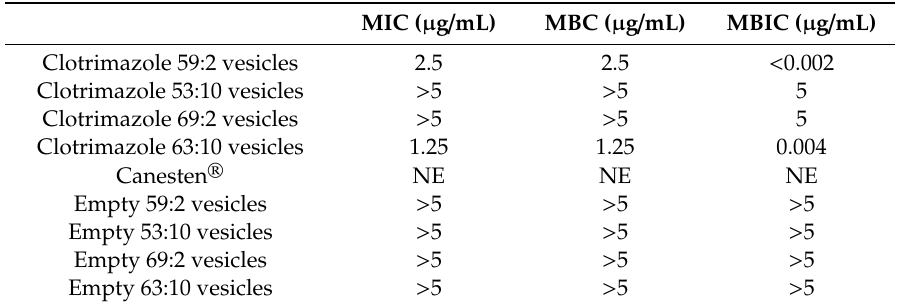
Table 4. Values of MIC, MBC, and antibiofilm profile provided by clotrimazole-loaded, three- dimensionally-structured hybrid vesicles or Canesten ® cream. Mean values ± standard deviation are reported. Canesten ® values were not evaluated (NE) since it formed a turbid dispersion, which interfered with the spectrophotometric measurements.